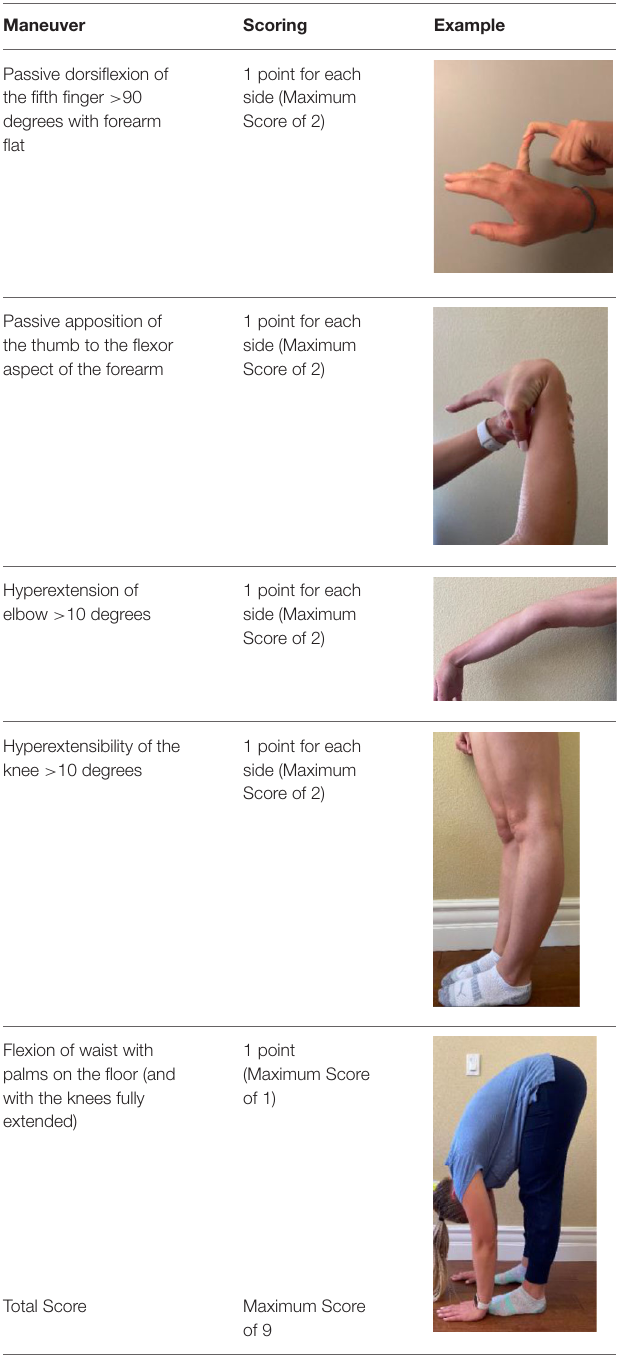
TABLE 1 | Beighton score for hypermobility. TABLE 2 | Brighton